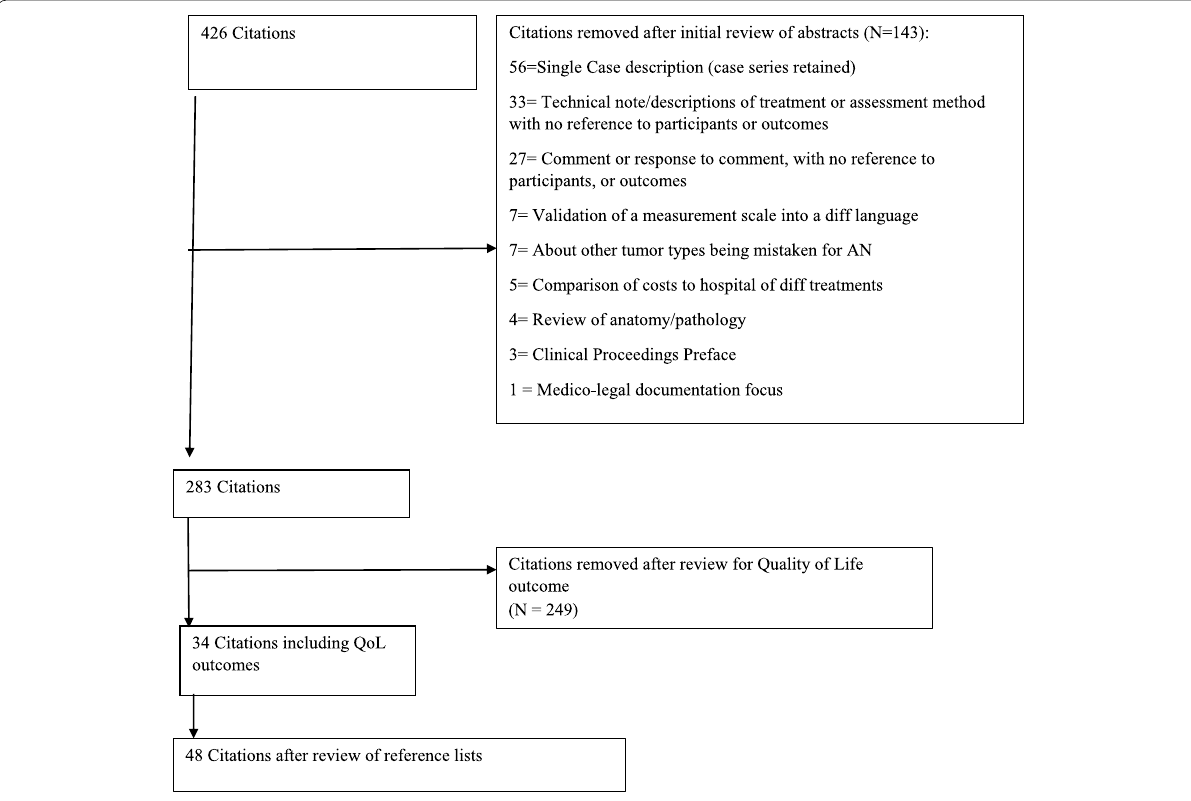
Fig. 1 Preferred Reporting Items for Systematic Reviews flowchart of citations